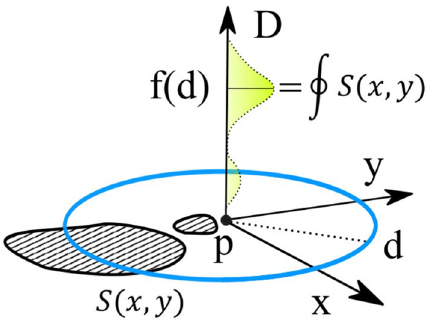
Figure 3. A tensor space D describes the distribution of distances at every point p to the image data surface S ( x , y ) , where the value at each position of the tensor D d corresponds to a distance d from point p and contains the contour integral of the surface S ( x , y ) around the circle at distance d from the point. In this way the tensor space D represents the density function of distances at all points in the surface to all other points in the surface. Equidistant points in the surface S ( x , y ) will generate peaks in the distribution along D and correspond to a symmetry